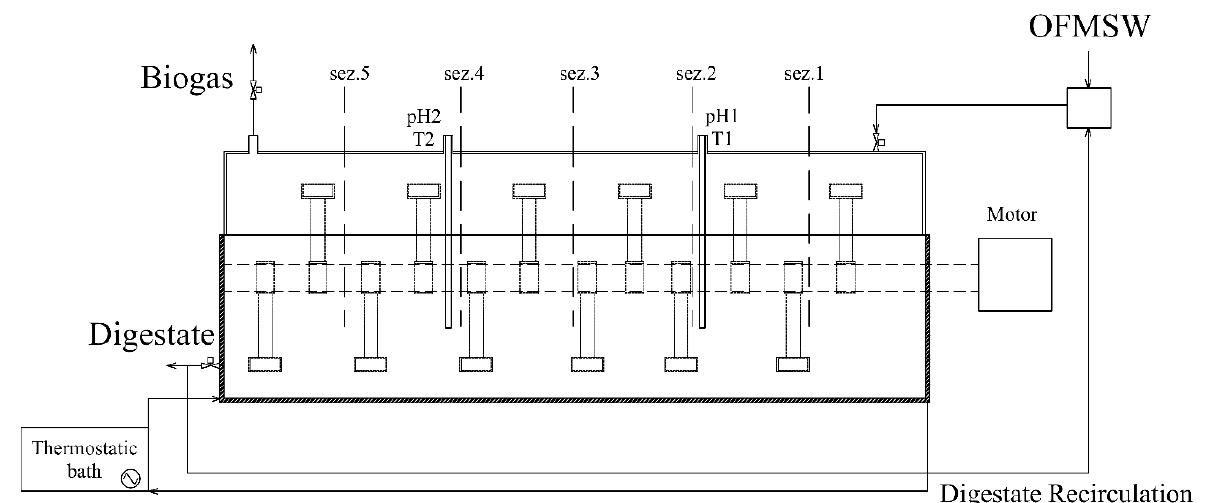
Figure 1. Schematic view of plug-flow reactor (PFR) and digestate sampling sections (sez.1 – sez.5).